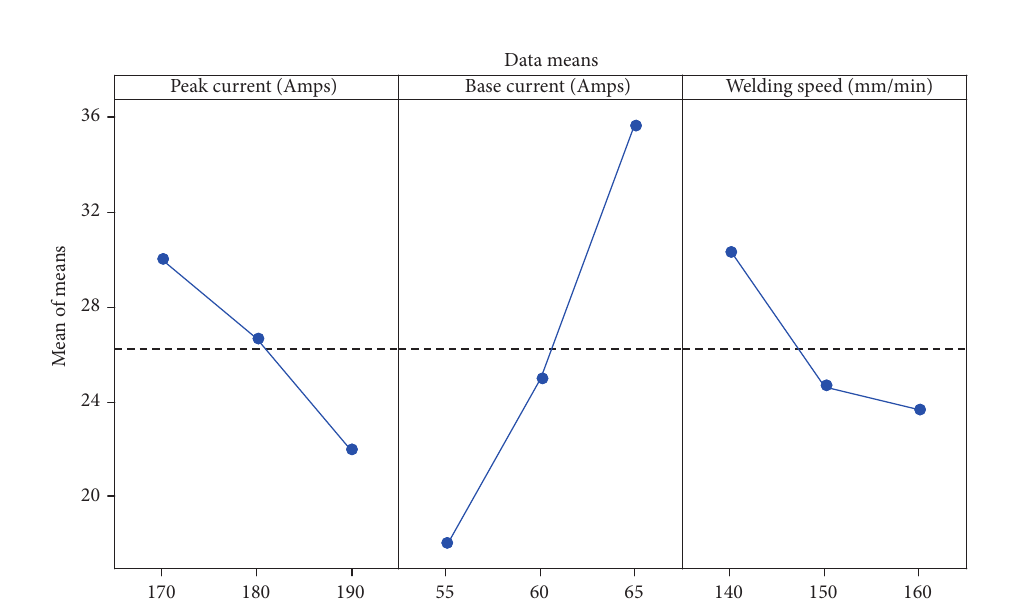
Figure 9: Main effect plot for